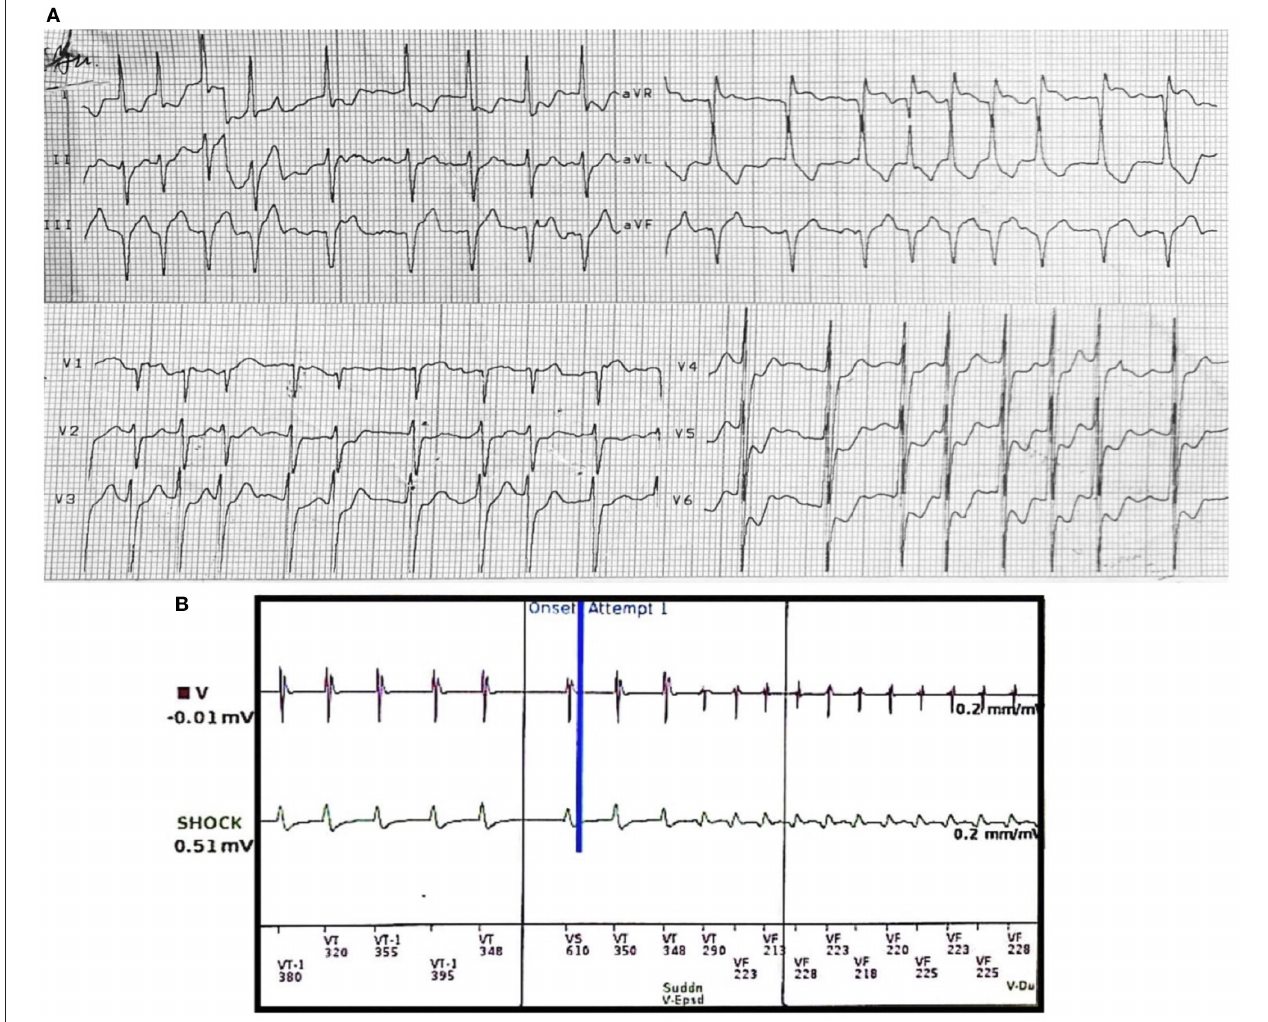
FIGURE 1 | (A) EKG during hemodialysis prior to ventricular tachycardia initiation. Rapid ventricular response atrial fibrillation with new-onset V4–V6 ST-segment depression and aVR ST-segment elevation. (B) Intracardiac electrograms (EGMs) showing induction of VF-zone monomorphic ventricular tachycardia (constant cycle lengths and EGMs with new-onset morphology) after intradialytic onset of paroxysmal rapid ventricular response atrial fibrillation (irregularly irregular cycle lengths). VF, ventricular